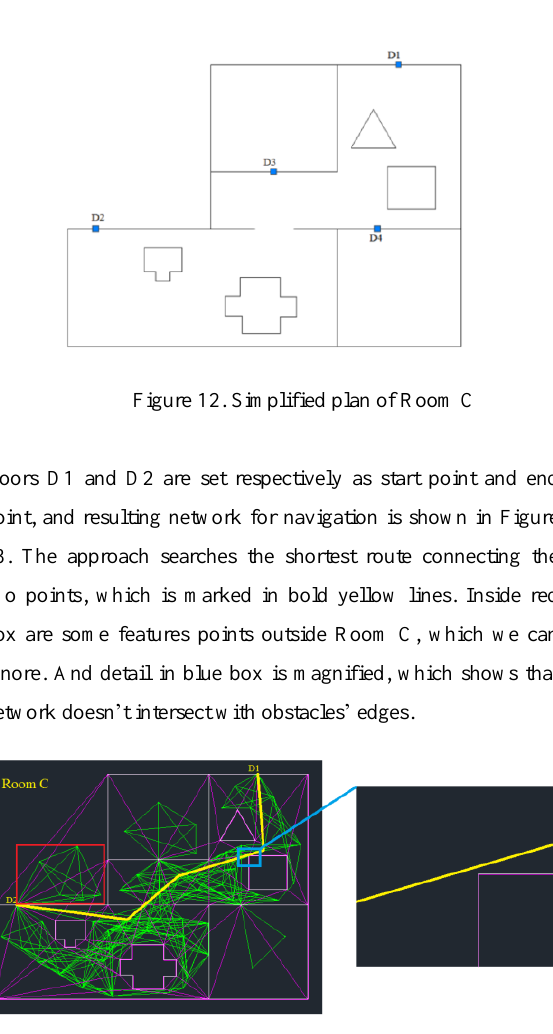
Figure 13. Resulting network for navigation (green) and the shortest path (bold yellow)